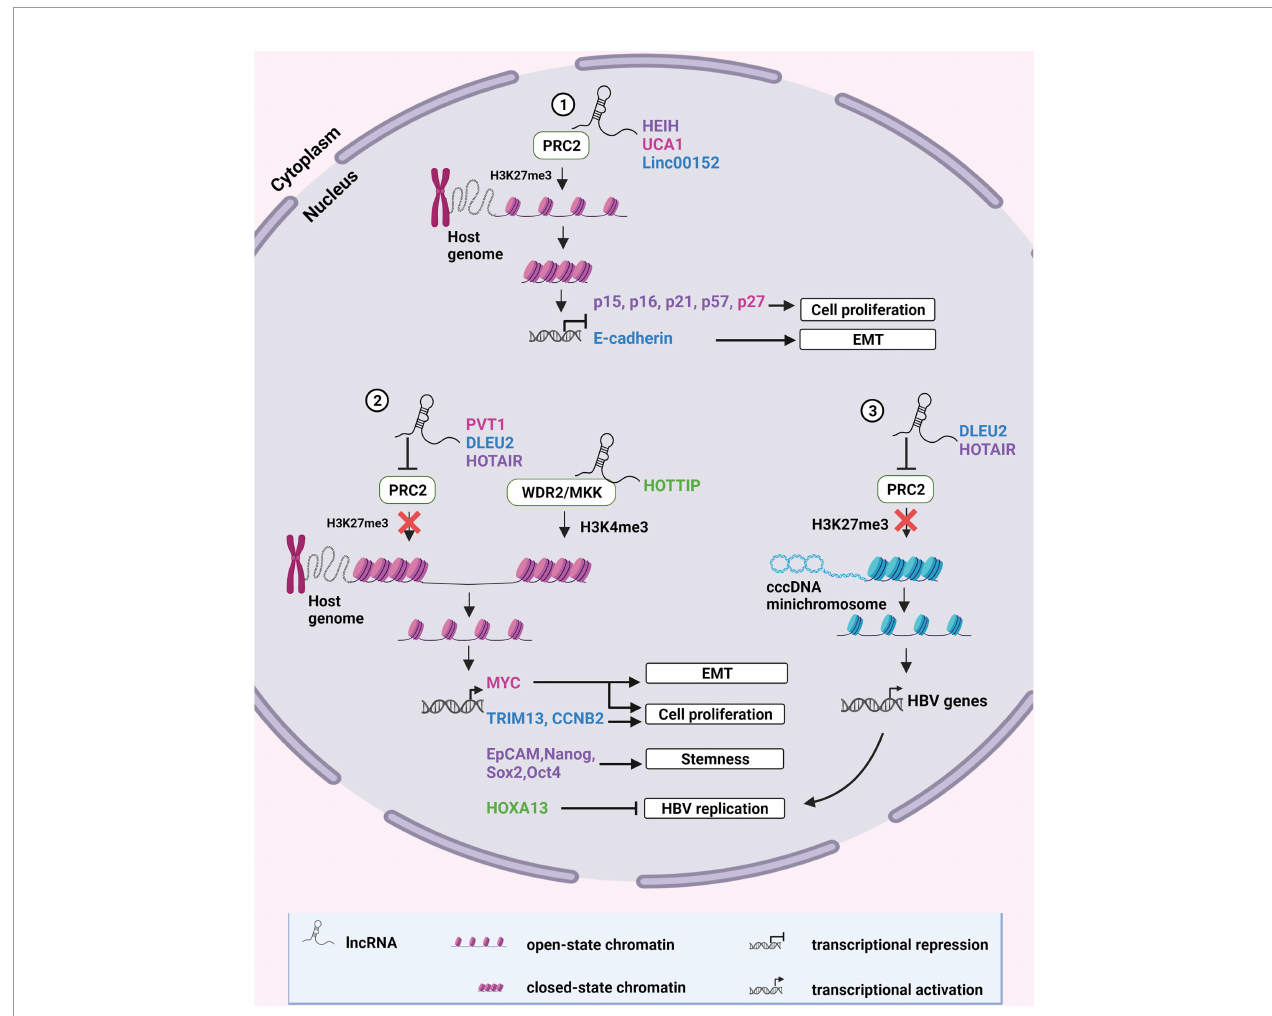
FIGURE 1 | Epigenetic modi fi cation of chromatin by lncRNAs. (1) LncRNAs HEIH, UCA1 and Linc00152 recruit the repressive chromatin modifying complex, PRC2, to speci fi c sites on the human genome to catalyze H3K27 trimethylation. This results in chromatin compaction and transcriptional repression of tumor suppressor genes. (2) LncRNAs PVT1 and HOTAIR inhibit formation of the PRC2 complex whereas DLEU2 displaces PRC2 from chromatin to prevent H3K27 methylation, allowing transcription of oncogenic host genes. HOTTIP recruits the activating chromatin-modifying complex WDR2/MKK to mediate H3K4 methylation of chromatin enabling the transcription of HOXA13 which suppresses HBV replication. (3) DLEU2 and HOTAIR can also inhibit PRC2 recruitment to HBV cccDNA, alleviating epigenetic silencing and promoting HBV replication. Color coding of names indicate a functional relationship between the lncRNA and its target. Created with